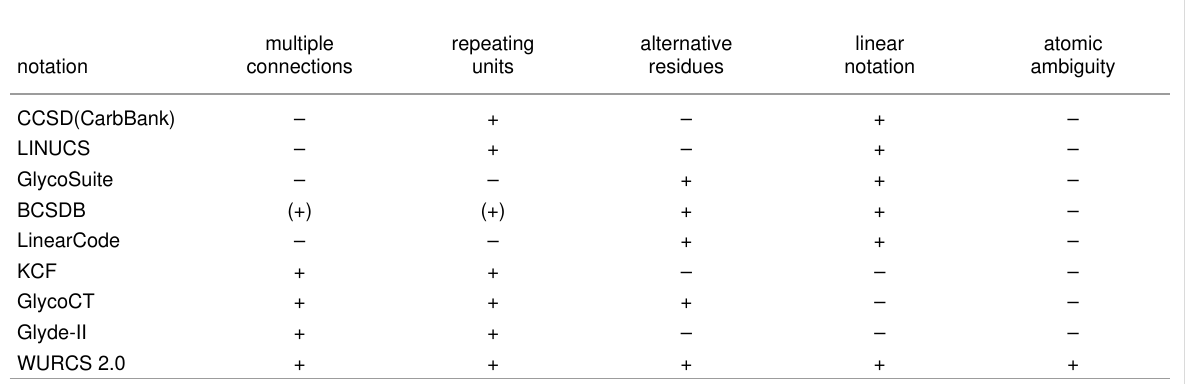
Table 1: A comparison of the structural information storage capabilities of different sequence formats used in glycobioinformatics.